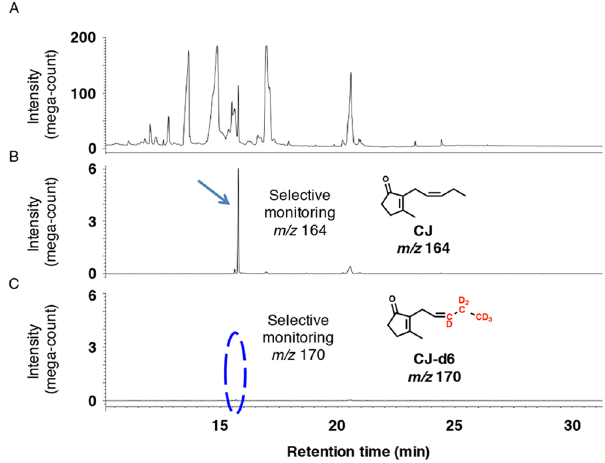
Figure 7. Representative GC-MS chromatograms for measuring CJ in feeding experiment using OPC8-d6. ( A ) Representative GC-MS chromatogram monitoring total ion. ( B ) Representative GC-MS chromatogram for measuring fungal derived CJ using selected ion monitoring at m / z 164. ( C ) Representative GC-MS chromatogram for measuring fungal derived CJ-d5 using selected ion monitoring at m / z 170. Representative MS chart of the peak indicated by arrow is given in Supplementary Figure